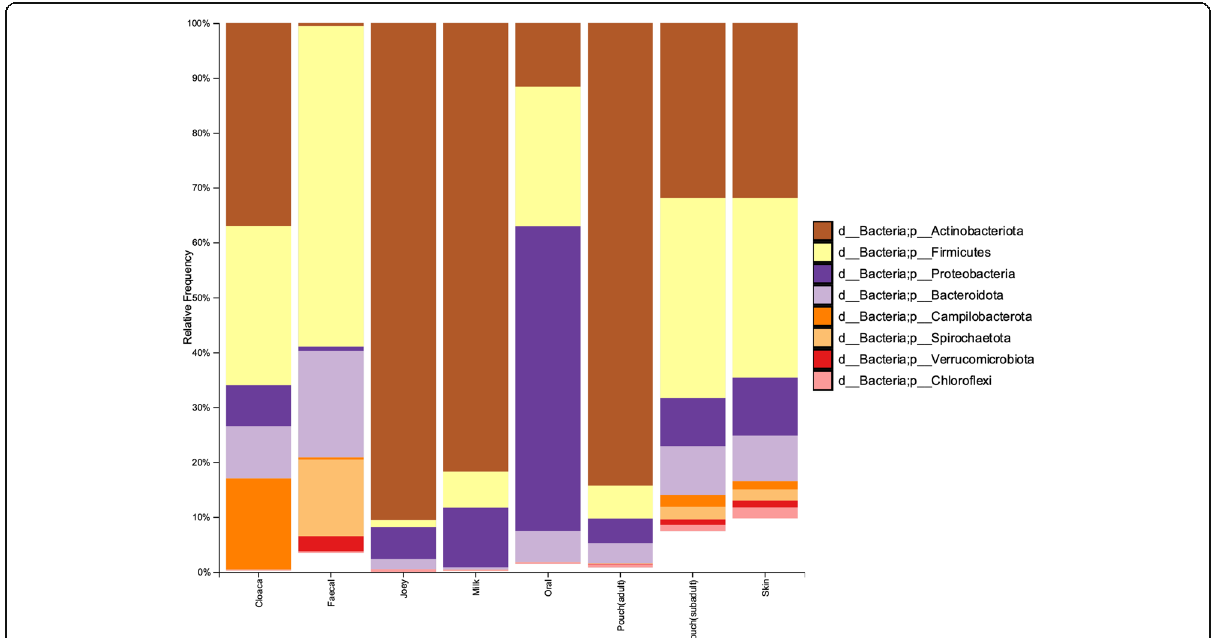
Fig. 5 Bar chart showing the phylum-level grouped (mean) relative abundance of microbial communities found at the different SHNW body sites. Only the 8 most abundant phyla are displayed. See SI file 1 for the .qzv file containing taxonomy at different levels. Joey= joey skin, oral, and cloaca